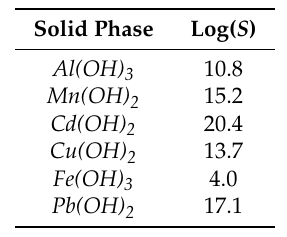
Table 2. Solid phases and solubility constants included in the model [10].